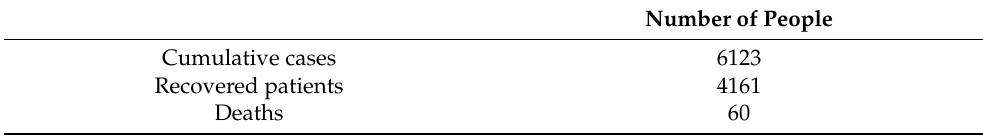
Table 1. COVID-19 data in Thailand as 27th December